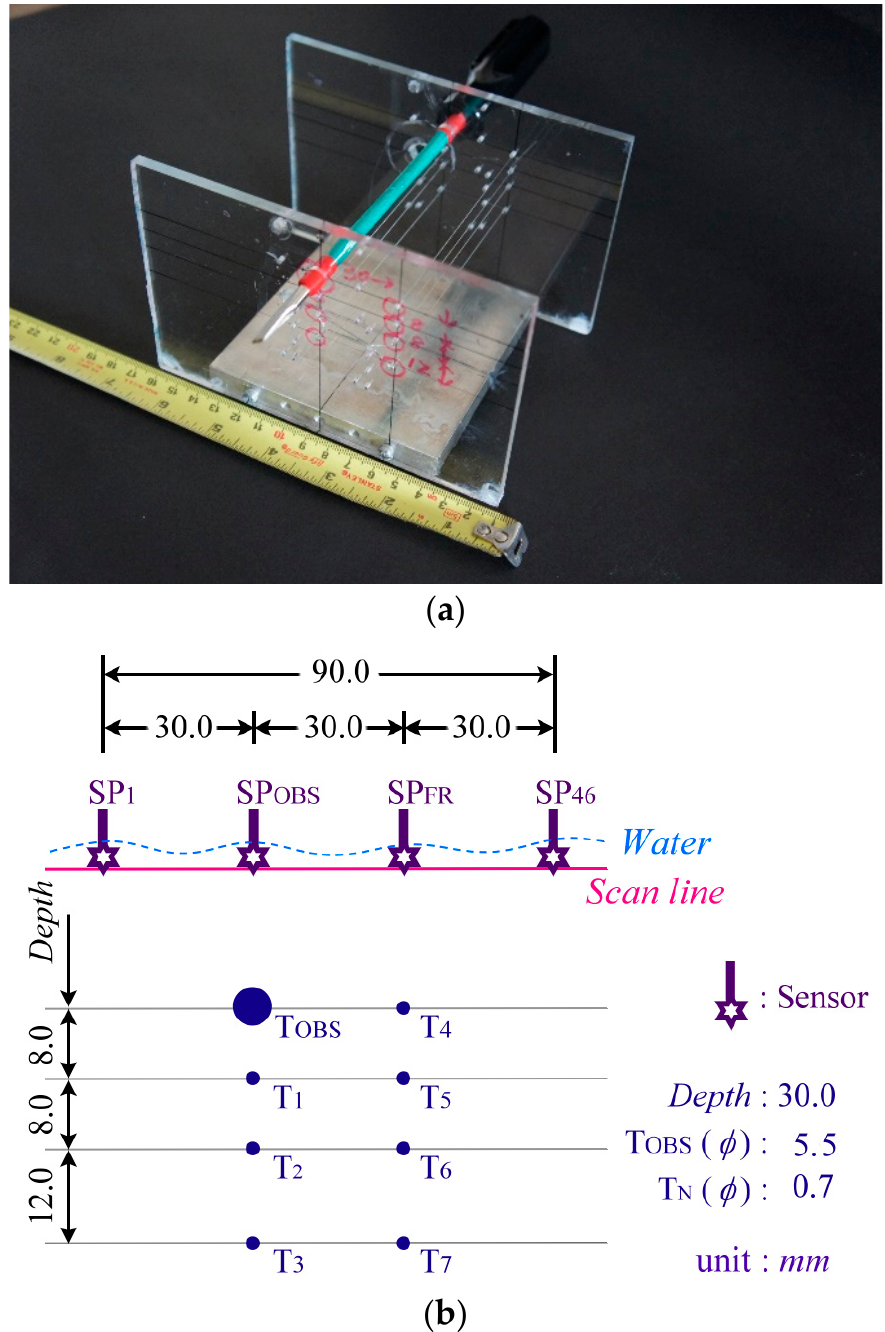
of the alignment lines are perpendicular to the scan surface (Figure 1b). The pink dot-line shown in Figure 1 indicates the scan line. SP OBS and SP FR located on the dot-line are two specific scan positions to perform shadowed and shadow-free scans.